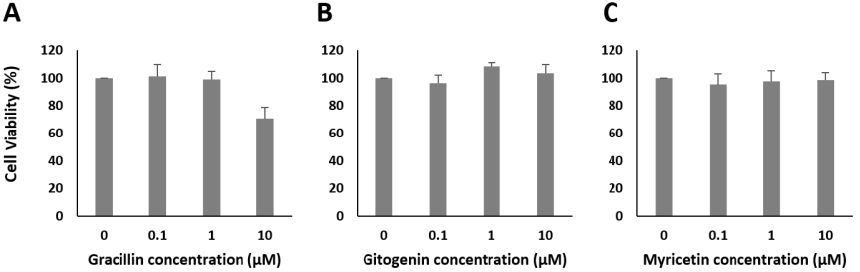
Figure A4. Cell viability of MIN6 pancreatic beta cells dependent on different concentrations of selected bioactive compounds: ( A ) Gracillin, ( B ) Gitogenin and ( C ) Myricetin.